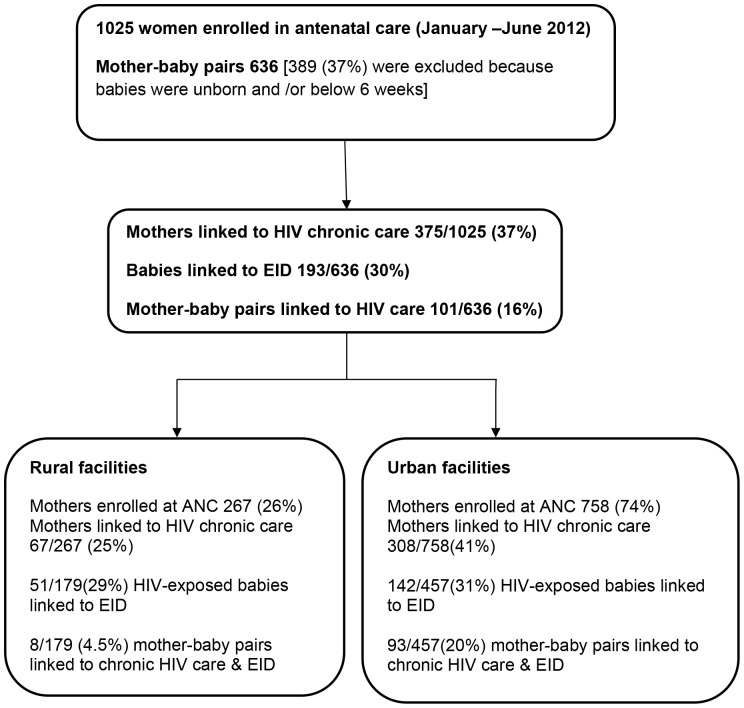
HIV-infected mothers and exposed infants followed up for six weeks post-delivery within the national PMTCT program.
Mothers ‘linked' to HIV/AIDS care were HIV-positive mothers recorded in the antenatal register, that appeared in the facility pre-ART register and had a clinic number with at least one clinical visit recorded by a clinician six weeks post-delivery. Babies ‘linked' to Early Infant Diagnosis (EID) were babies born to HIV-infected mothers (as per antenatal and labor registers), that were registered in the facility EID register with at least one clinical visit recorded by a clinician by six weeks post-delivery. Mother-baby pairs ‘linked' were mother-baby pairs identified from the antenatal and labor ward registers, that had the HIV-infected mother registered in the HIV clinic and the baby registered in the EID program by 6 weeks post-delivery. Babies ‘not eligible' were unborn and/or below 6 weeks of age at the time of the study were excluded.